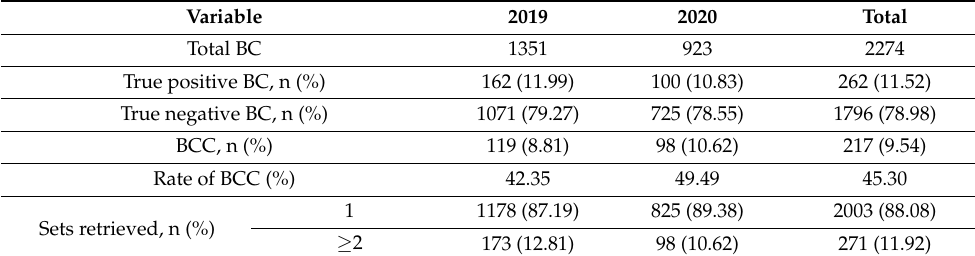
Table 1. General characteristics of blood cultures performed at the hospital in